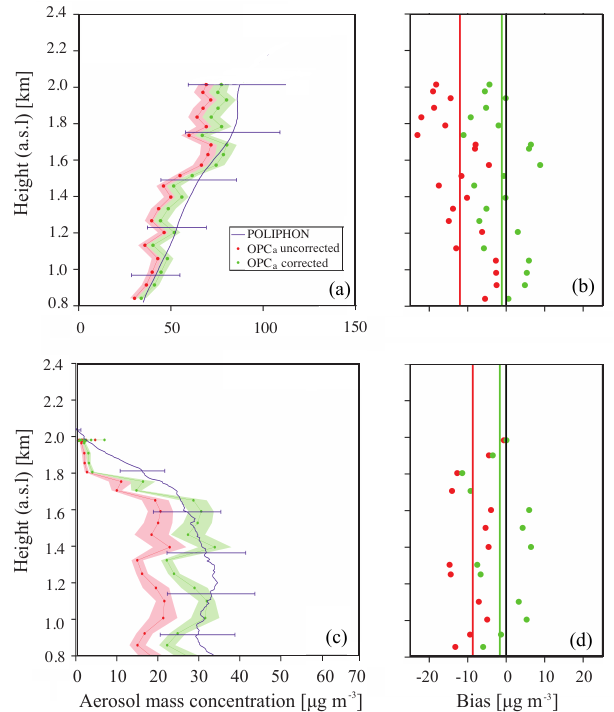
Figure 11. Aerosol mass concentration profiles for case studies I and II (a, c) and the respective biases (b, d) . In plots (a) and (c) , the blue solid lines represent the mass concentration derived by the POLIPHON. The mass concentration measured by the OPC a is plotted in red with the red shaded area representing the uncer- tainties in the in situ measurement. The green lines show the mass concentration from the OPC a corrected for the particles losses. In plots (b) and (d) , the red dots show the biases between the values measured by the OPC a and the lidar (OPC a –lidar) before applying the corrections, while the green dots are the biases after corrections. The red and green solid lines show the mean biases before and after correction,